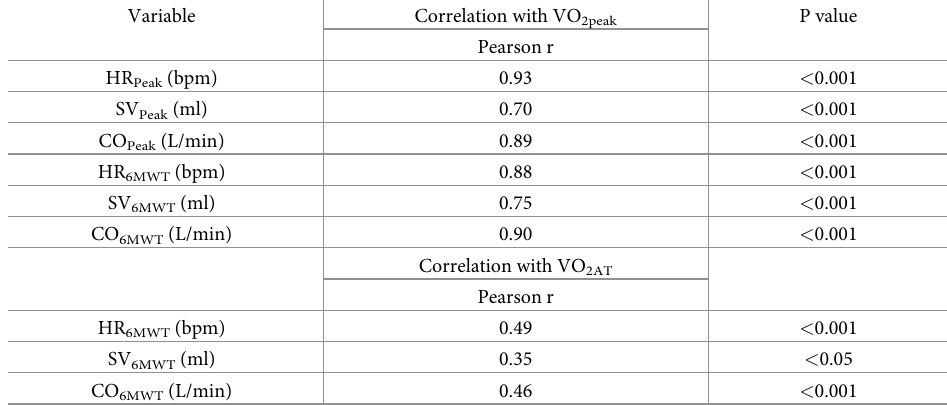
Table 3. Correlations of VO 2peak with peak HR, SV and CO measured by ICG during 6MWT and CPET and corre- lations of VO 2AT with peak HR, SV and CO measured at the end of 6MWT. Variable